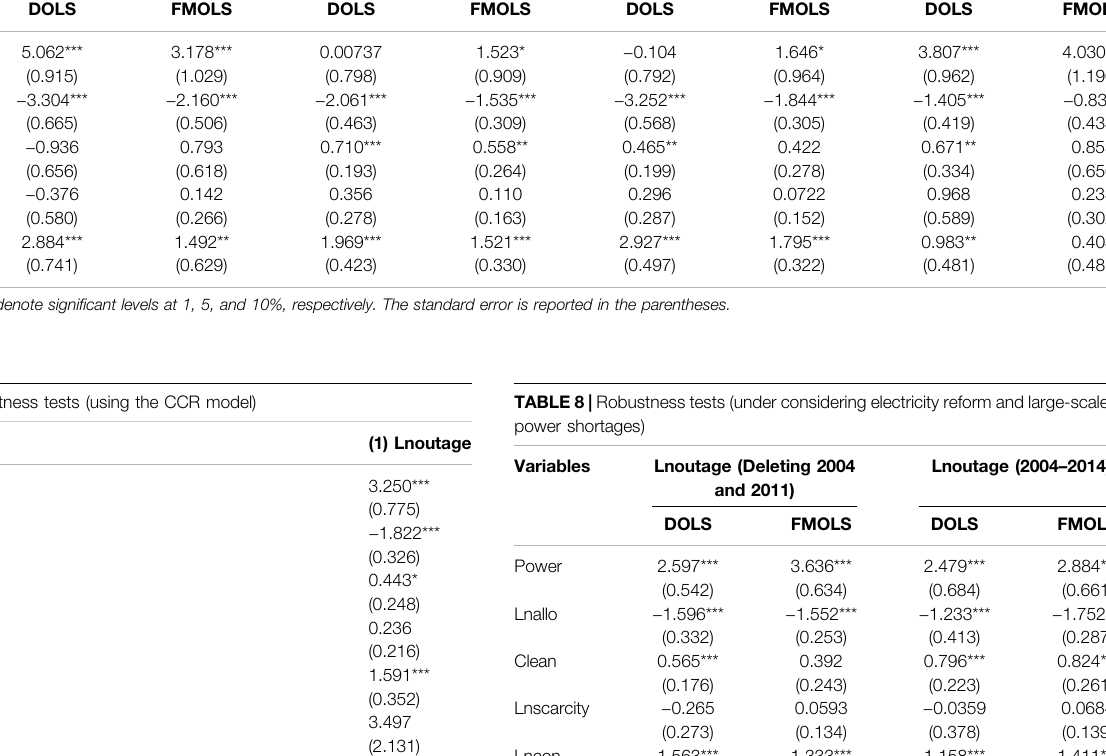
TABLE 5 | Heterogeneity test Variables